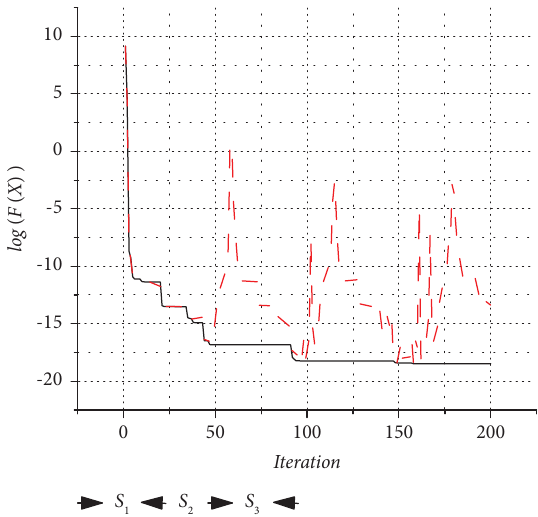
Figure 7: Tree-stage sketch of particle swarm evolution under GB-PSO. Table 4: Mean and standard deviations of the function